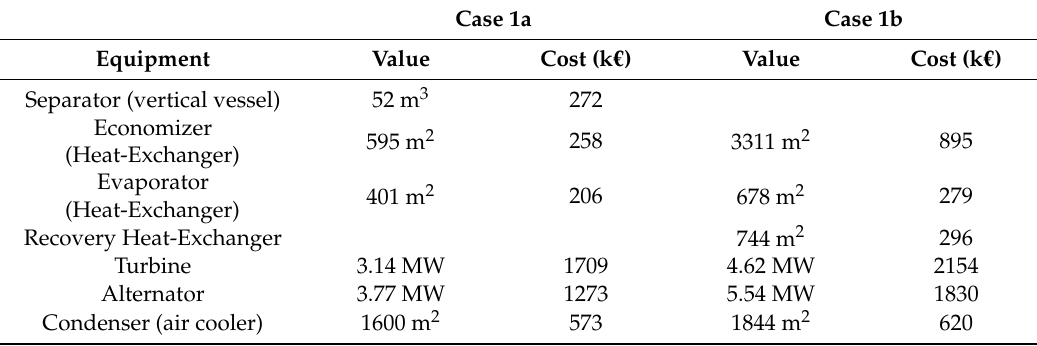
Table 4. Capital expenditure (CAPEX) and profitability estimation for ORC (case study 1a and Table 3. Results of the process basic design–energy recovery for case studies 1a and 1b.